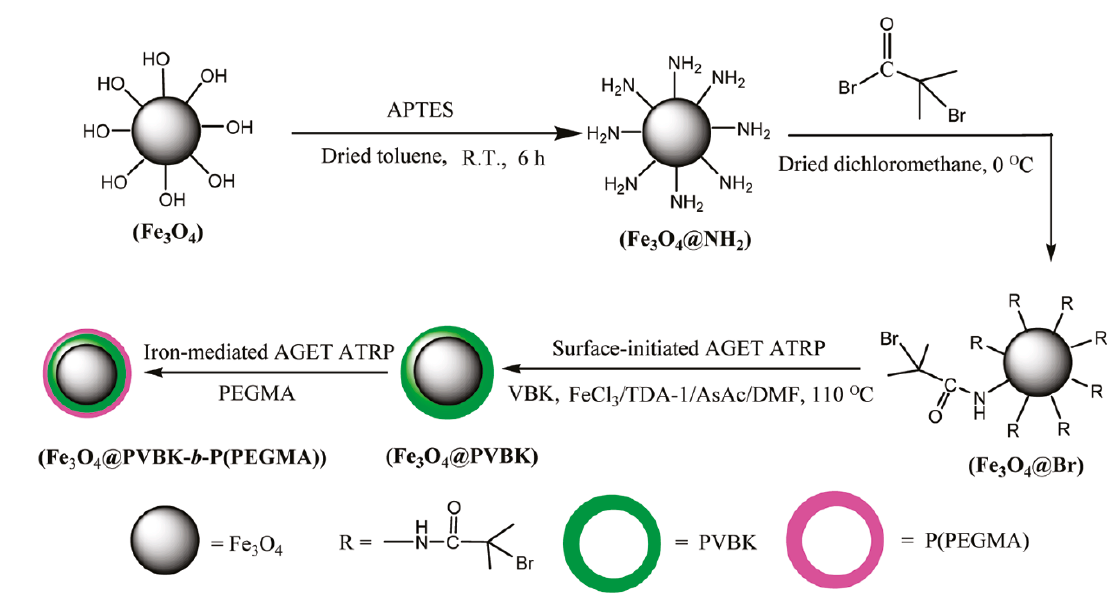
Figure 5. Synthetic route for the preparation of fluorescent/magnetic nanoparticles via iron-catalyzed ATRP [133]. Reprinted with permission from American Chemical Society, Copyright 2011.